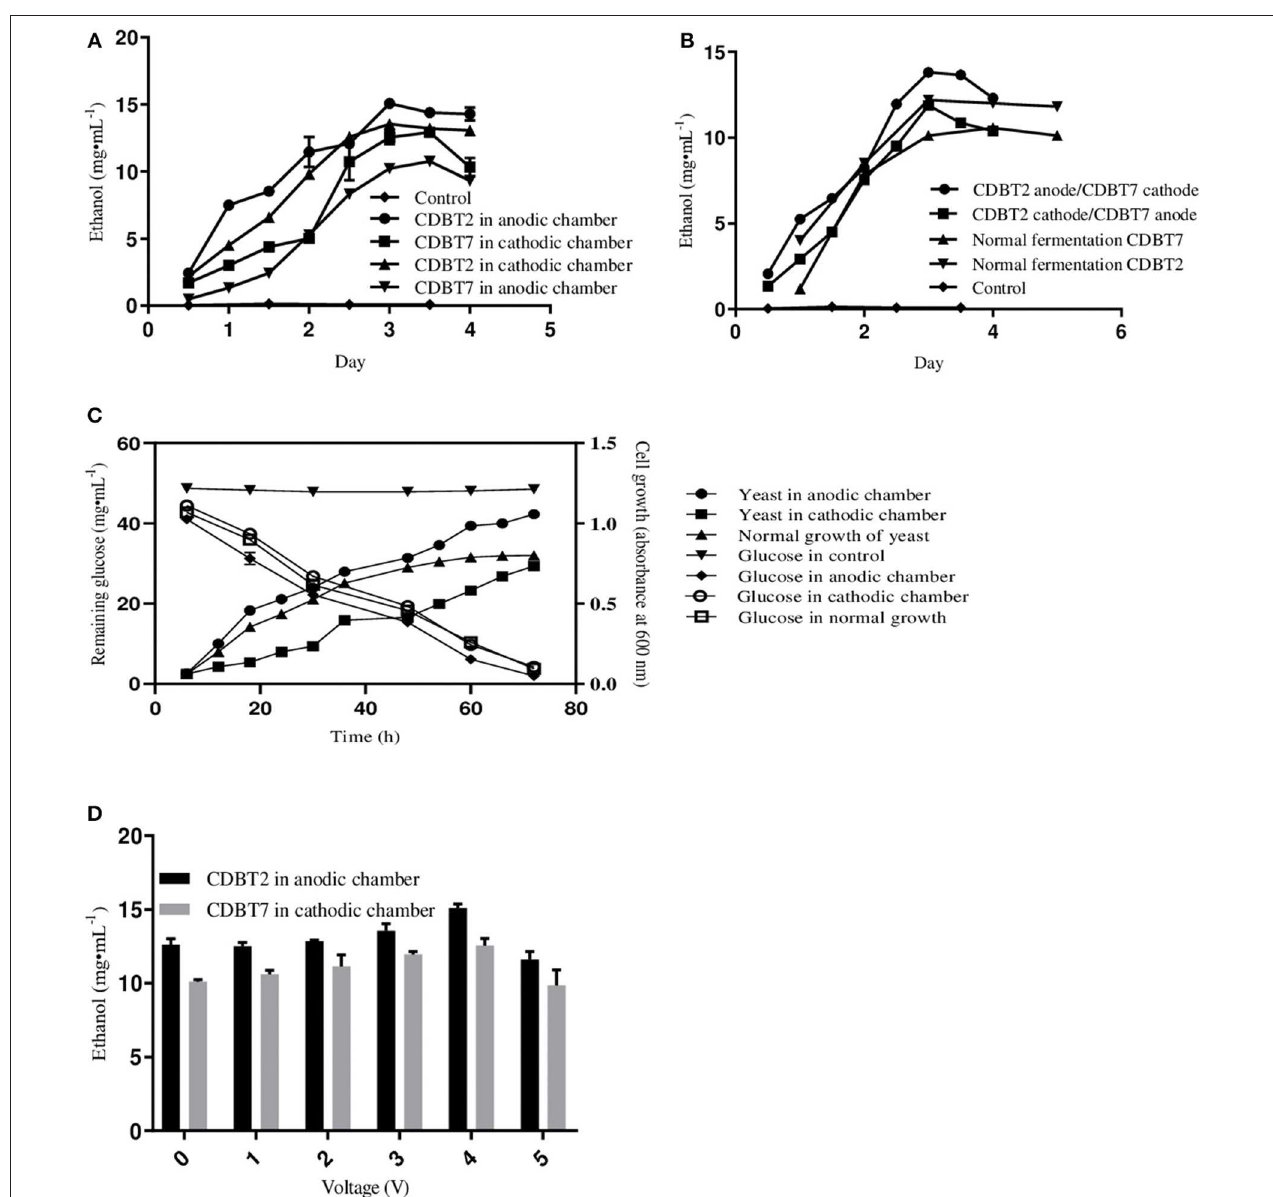
FIGURE 2 | Ethanol production in ECC by yeast strains CDBT2/CDBT7 with the supply of 4V externally. (A) Ethanol production in cathodic and anodic chambers by CDBT2 and CDBT7 individually. (B) Average of ethanol production in both chambers. (C) Cell growth and glucose utilization when CDBT2 cultured in anodic and cathodic chambers with and without applied external voltage (normal growth—without the supply of external voltage). (D) Effect of applied electrical current on ethanol production by CDBT2 and CDBT7. (Control: ECC w/o/yeast culture and w/o voltage supply; normal fermentation: ECC w/o voltage supply).